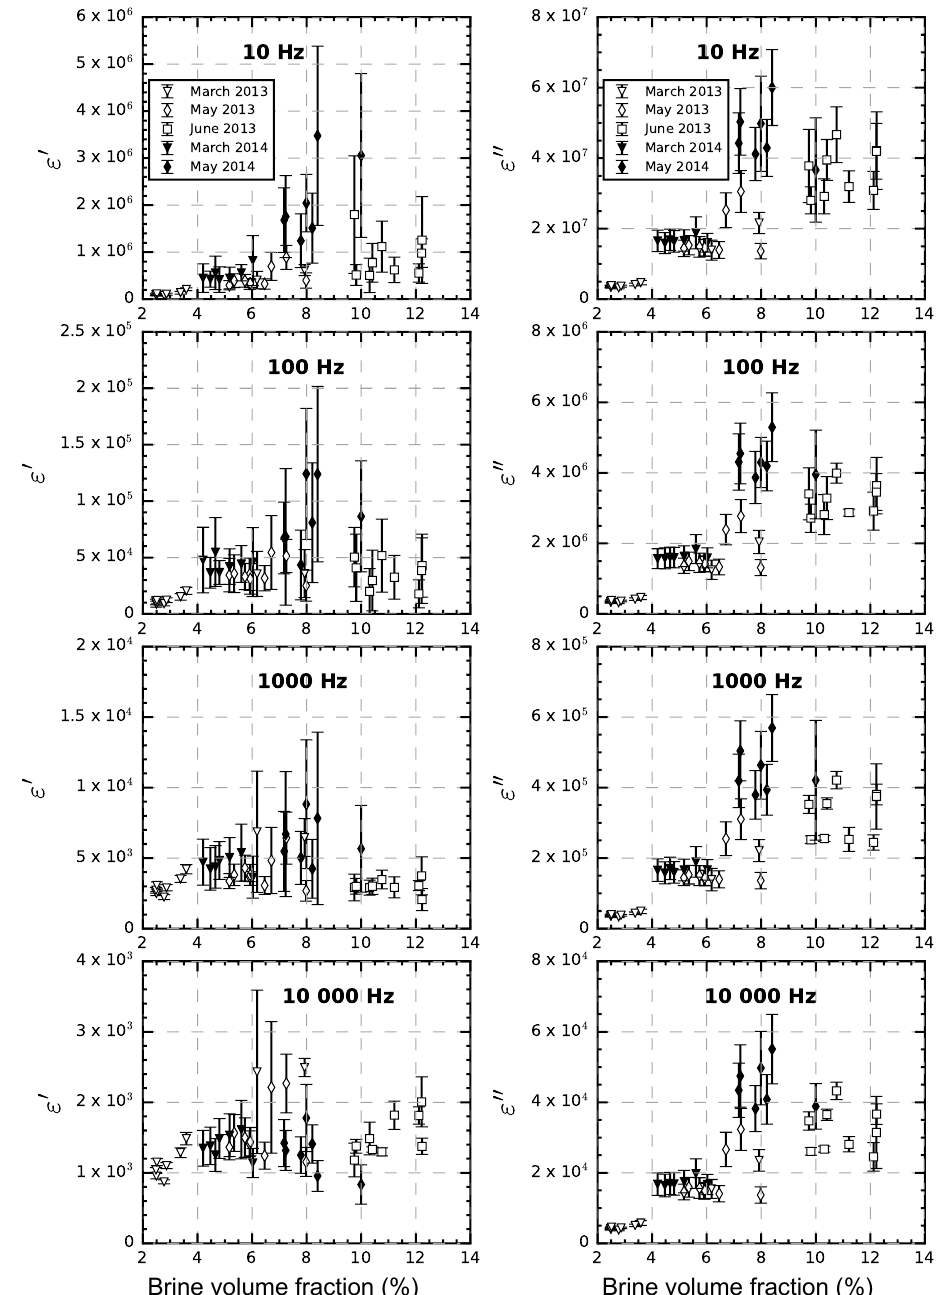
Figure 8. Variation of the real ( ε (cid:48) ) and imaginary ( ε (cid:48)(cid:48) ) parts of the measured permittivity as a function of brine volume fraction. Triangles: late March; diamonds: mid-May; squares: early June; open symbols: 2013; filled symbols: 2014.